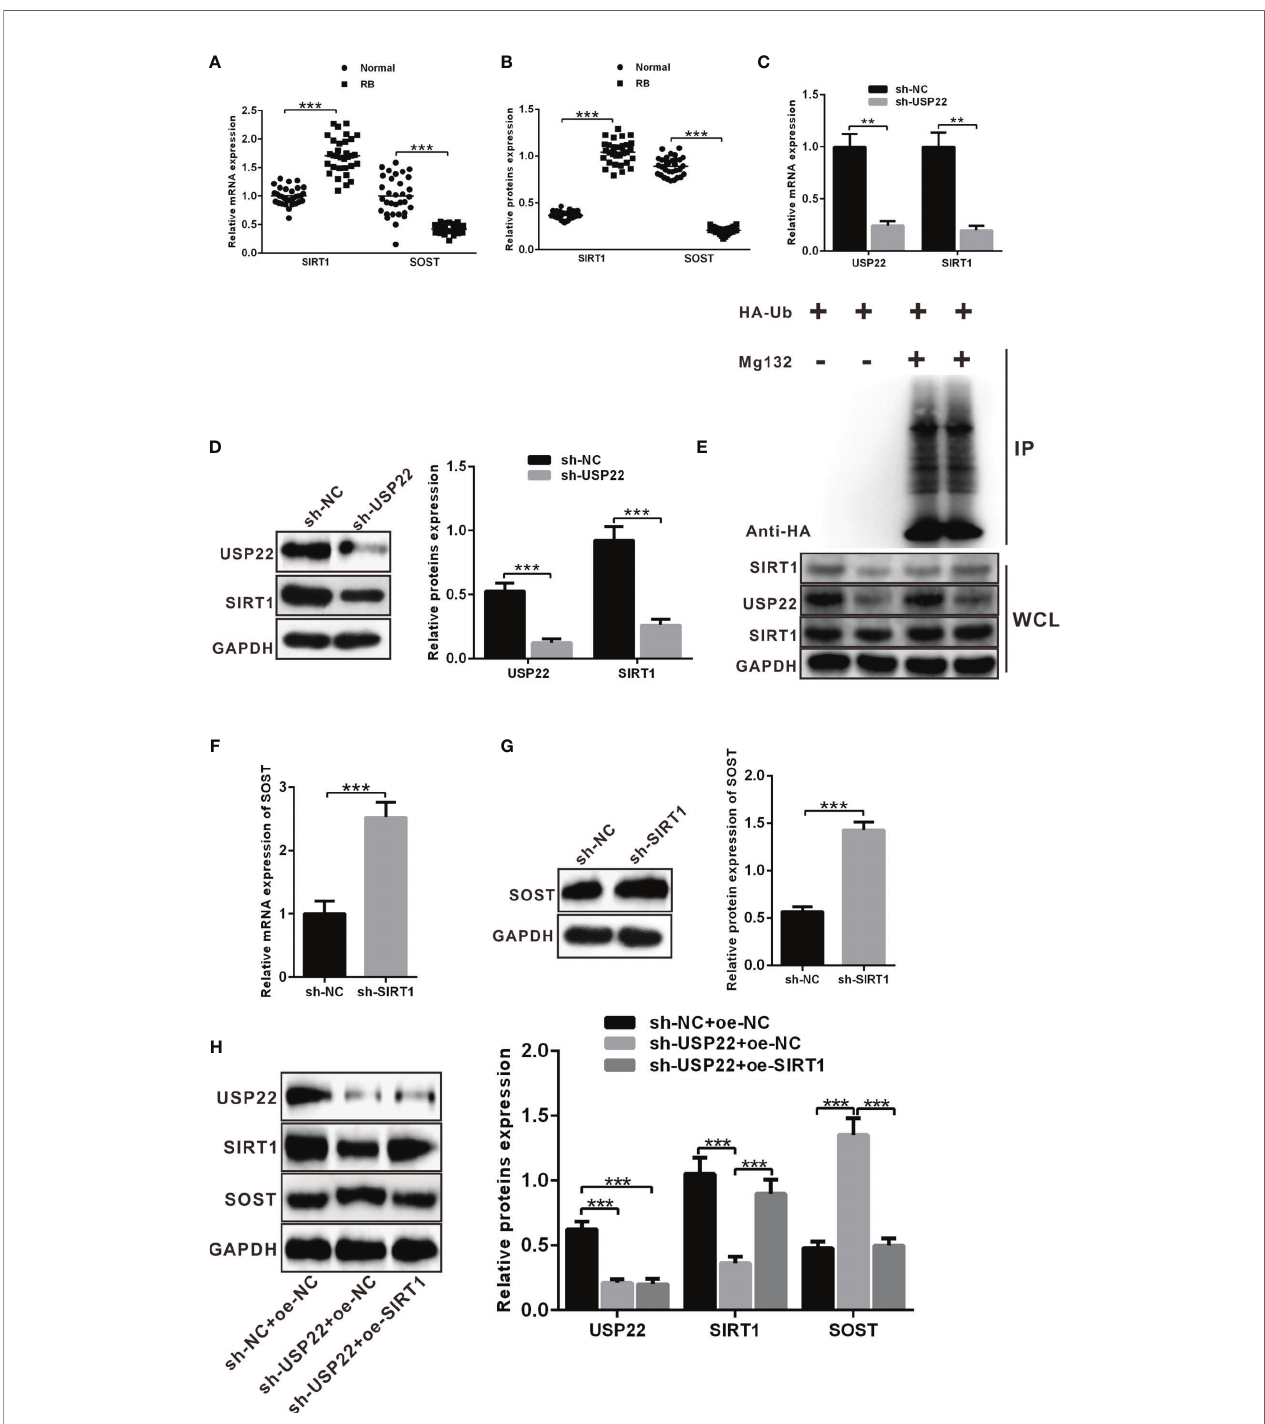
FIGURE 4 | USP22 positively regulates SIRT1 expression through deubiquitination to suppress the expression of SOST. (A, B) SIRT1 and SOST expression in clinical samples was measured using RT-qPCR and western blot analysis (n = 32). (C, D) SIRT1 expression was detected when USP22 expression was knockdown using RT-qPCR and western blot analysis. (E) Deubiquitination of SIRT1 by USP22 was veri fi ed in Y79 cells and WCL was an abbreviation of whole cell lysates. (F, G) SOST expression was detected when SIRT1 expression was silenced using RT-qPCR and western blot analysis. (H) The expression of SOST was regulated by SIRT1 and USP22 detected by western blot analysis. ** p < 0.01, *** p < 0.001. The measurement data was expressed by mean ± standard deviation. The two groups of data conforming to the normal distribution were compared using unpaired t